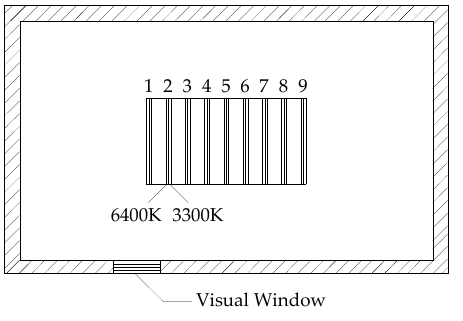
Figure 4. Arrangement of lamps.